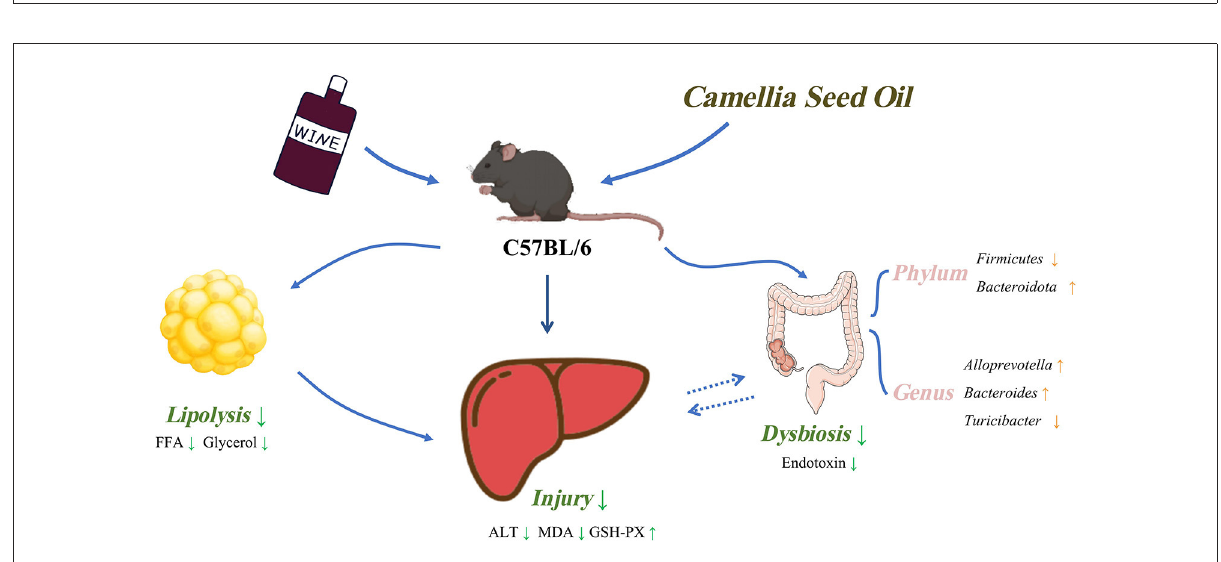
FIGURE8 Schematic diagram of this